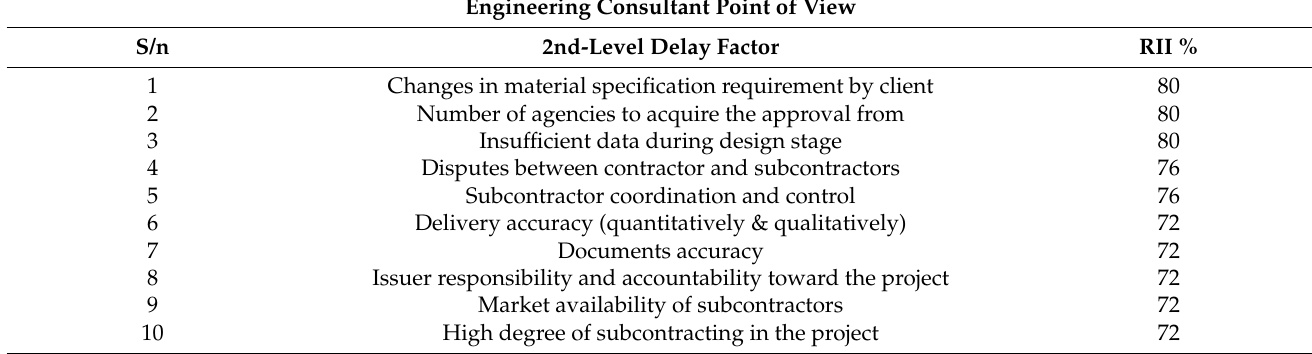
Table 12. Root cause in consultant point of